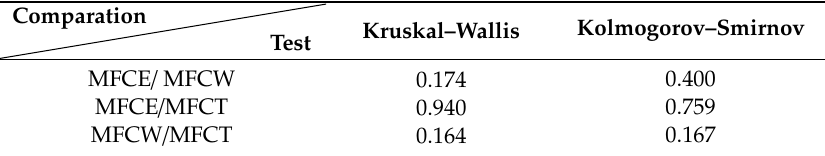
Table 2. Kruskal–Wallis and Kolmogorov–Smirnov tests for the Power densities. Comparation